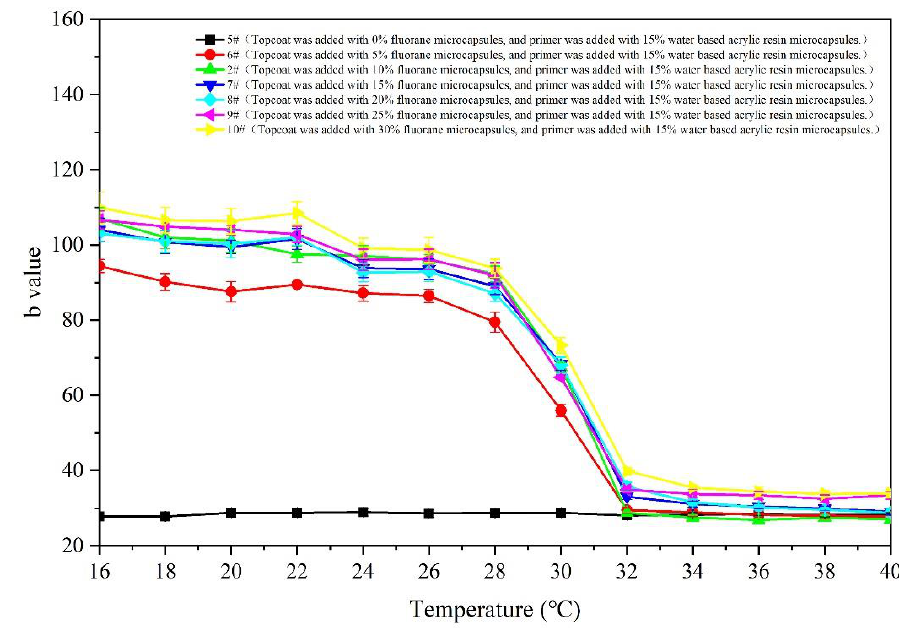
Figure 6. The temperature rise (16 °C to 40 °C) on b value of film.